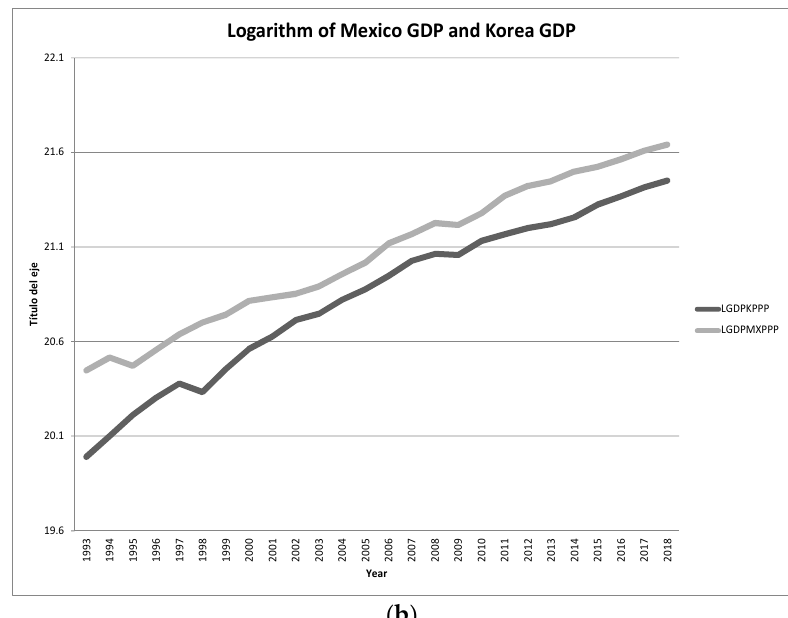
Figure 1. GDP, Exports and Imports in Mexico and South Korea, 1993–2018: ( a ) Imports and Exports Mexico-South Korea, logarithms; ( b ) Mexico’s GDP and South Korea’s GDP, logarithms. Source: authors’ using data from The World Bank [61].